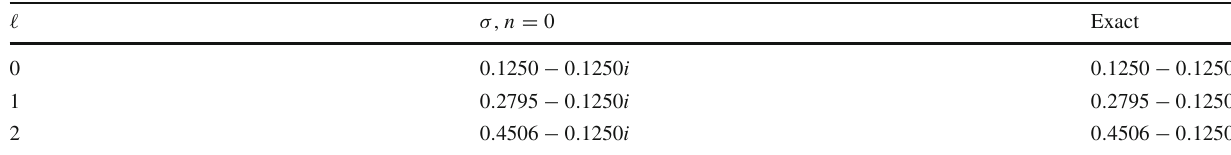
Table 5 Fundamental normal modes for massless scalar perturbations of the classicSchwarzschildmetric.The secondcolumn reports thefun- damental quasi-normal frequencies obtained by means of the improved